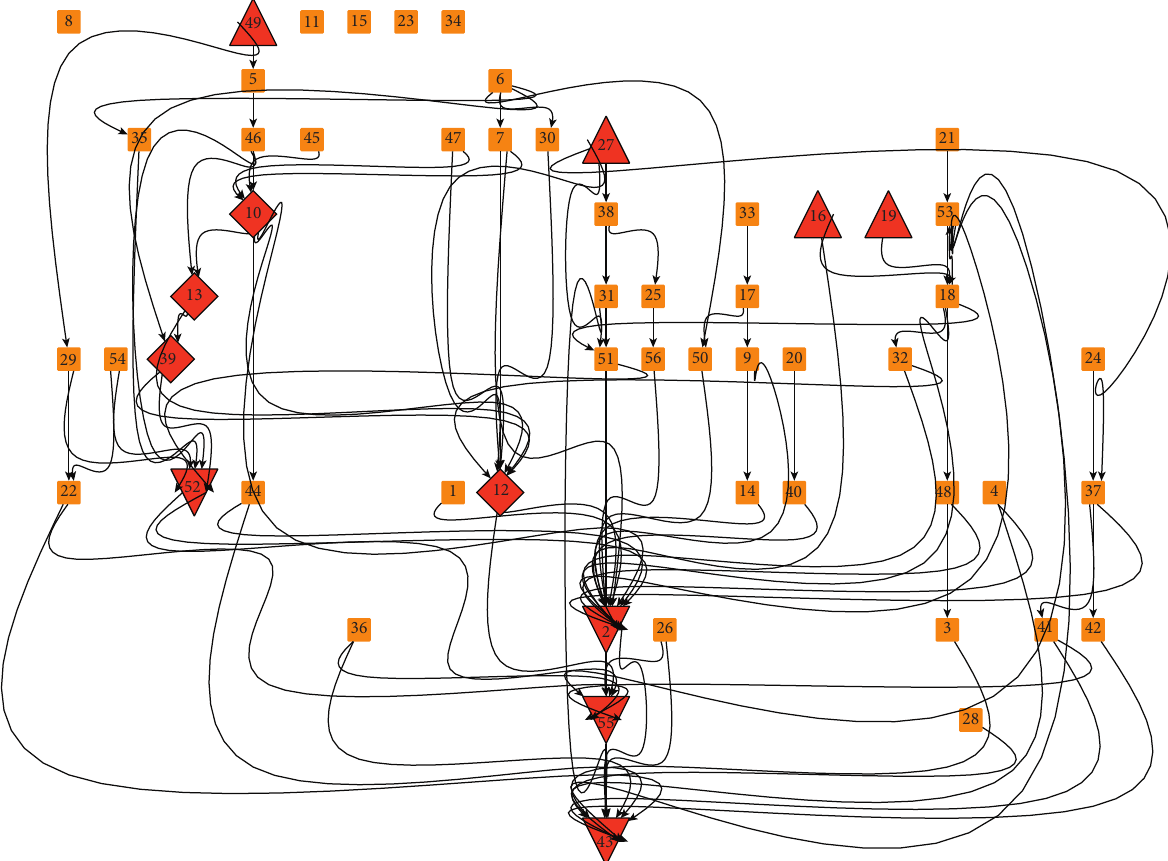
Figure 5: Illustration of a network theory-based analysis of project risk